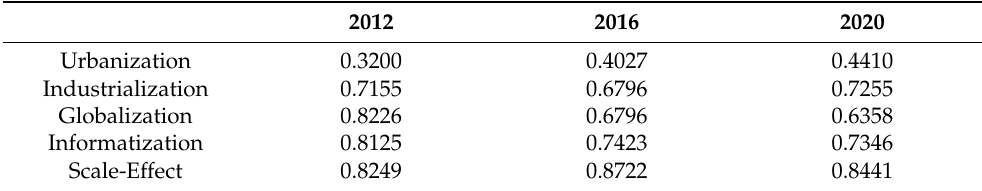
Table 4. Analysis of influencing factors of urban service-land